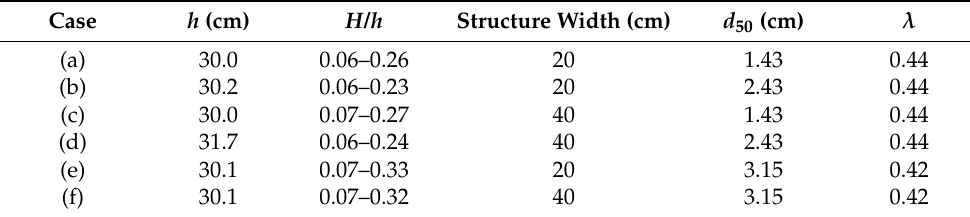
Table 2. Test cases of Vidal et al.’s experiments